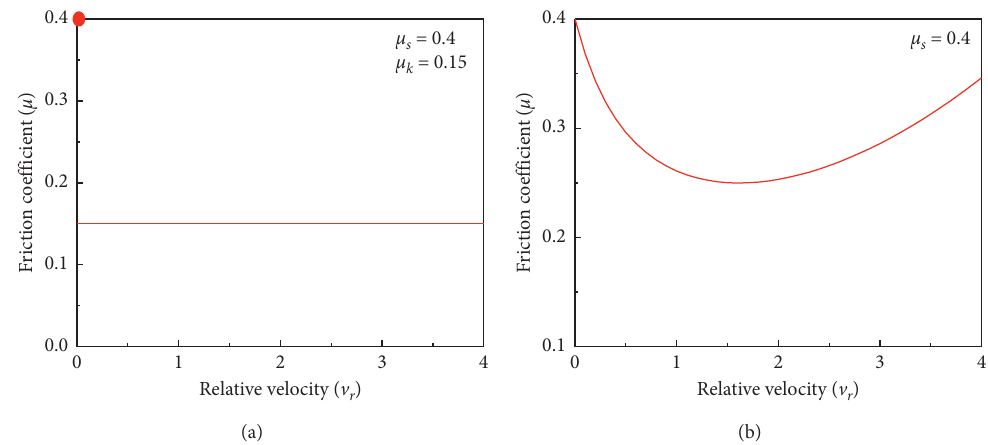
Figure 2: Friction law I: μ